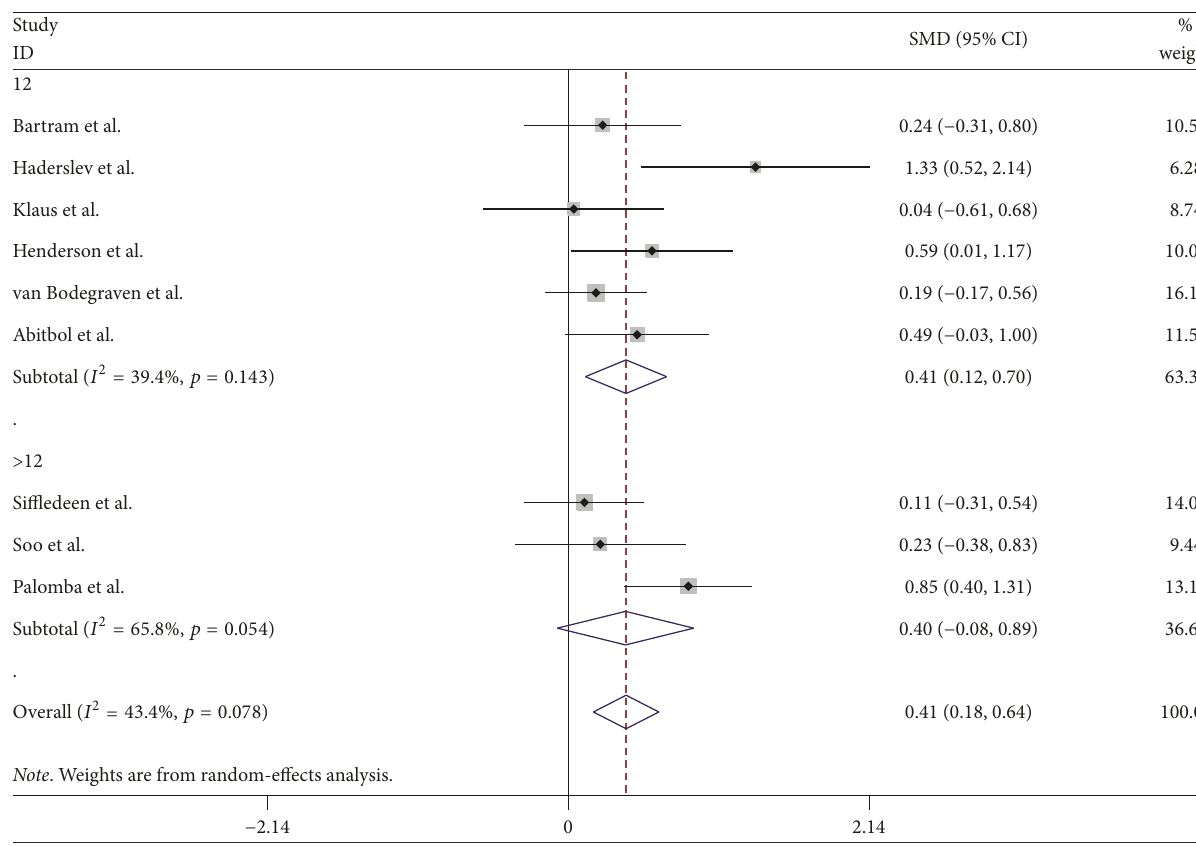
Figure 2: Randomized controlled trials of bisphosphonates in improving spinal BMD in IBD. Forest plot showing the weighted mean differences and 95% confidence interval of the percentage change in BMD in the lumbar spine in the bisphosphonate and control groups. A subgroup analysis of the treatment duration of the two groups is also shown.